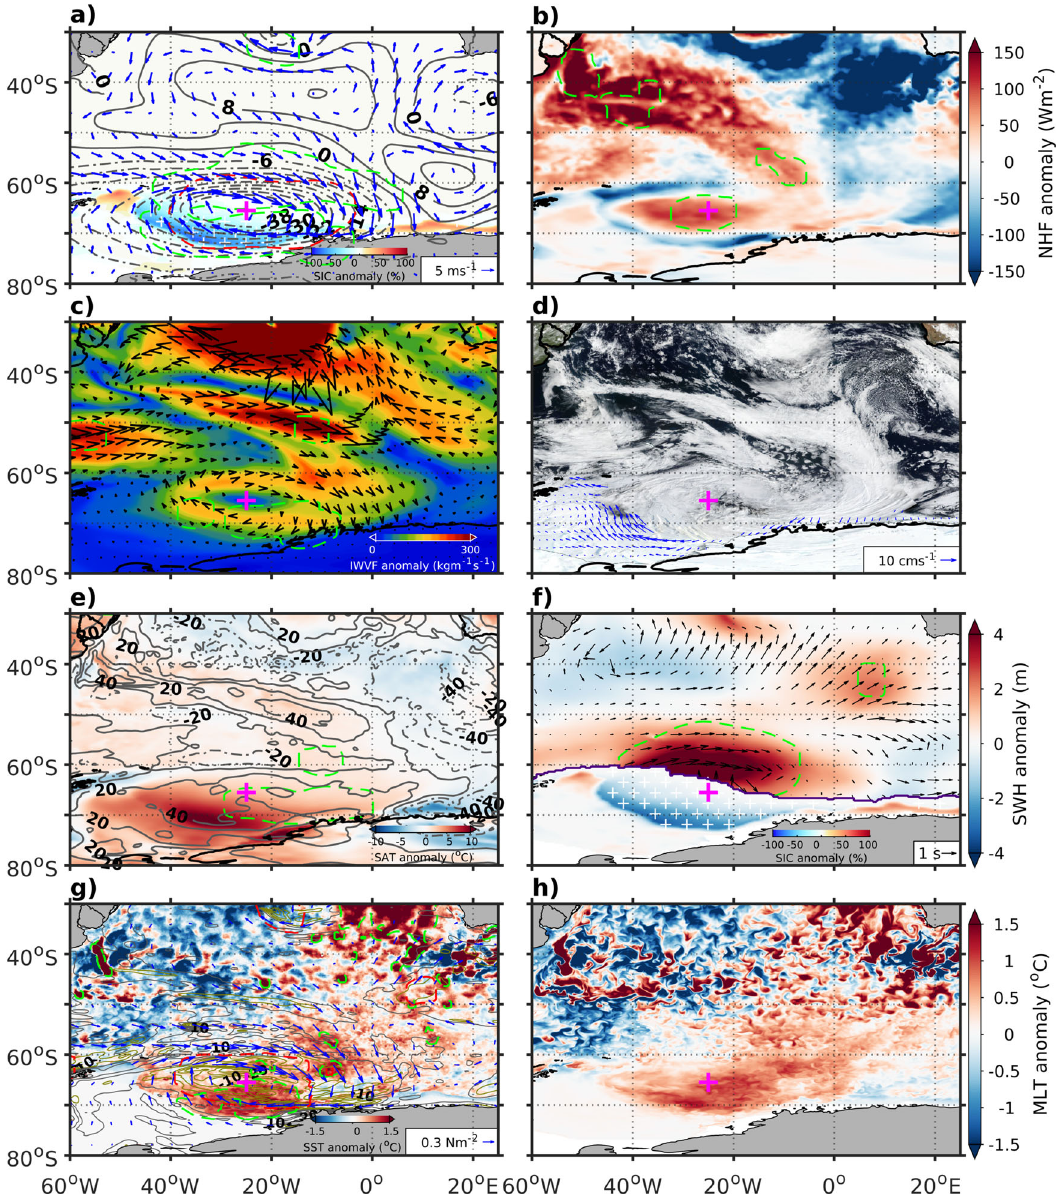
Fig. 3 Impact of the polar cyclone C1 on sea ice during 31 March 2019. a Anomalies of mean sea level pressure (MSLP) and wind vectors (blue arrows) are overlaid on anomalous sea ice concentration (SIC). Positive (negative) anomalies of MSLP are shown in solid (dashed) gray contours. The white plus marks showed the record low SIC values that remain outside from 1979 to 2020. b – e Anomalies in ( b ) net surface heat fl ux (NHF), ( c ) integrated water vapor fl ux (IWVF), ( d ) potential sea ice velocity (arrows) overlaid on cloud bands of cyclone from the Visible Infrared Imaging Radiometer Suite (VIIRS), ( e ) downward long-wave radiation (gray contours) overlaid on surface air temperature (SAT). f Signi fi cant wave height (SWH) anomalies are shown as color-shaded panel to the north of sea ice edge (purple line) with wave direction and period (black arrows) of combined wind waves and swells. The color-shaded panel to the south of the sea ice edge shows anomalous SIC. g, h Anomalies in ( g ) sea surface temperature (SST), wind stress vector (blue allows), negative wind stress curl (green contours, N m − 3 ), positive wind stress curl (gray contours) and ( h ) ocean mixed layer temperature (MLT). Regions within red (green) dashed polylines have record low (high) values that remain outside from 1979 to 2020. Within this, the record low is shown for MSLP and wind stress curl, while the record high is shown for other variables. The pink plus mark shows the low-pressure centre of the cyclone. The anomalies are computed relative to the climatology of 1979 – 2008. occurrence of intense and explosive cyclones (Fig. 4d, Table 1). The the impact of cyclone C1 induced extreme changes in ocean- slowdown of the ice melting/reduction occurs through enhanced atmospheric conditions initiated the rapid decline in SIE (0.024 ‒ snow accumulation which hinders the conduction-driven heat loss 0.032 × 10 6 km 2 day − 1 ) from 31 March to 4 April 2019 (Fig. 2c). It is at the interface between ocean and sea ice. Also, the snowfall also noted that the atmospheric rivers associated with polar during the polar cyclones provides the freshwater in fl ux to the cyclones bring enhanced precipitation 63 on sea ice cover which can ocean mixed layer that might have partly played a role by slowing slowdown the ice melting/reduction. Anomalously high precipita- down the ice melting/reduction. tion (~1.13 – 2.72 cm) in form of snowfall was observed during the npj Climate and Atmospheric Science (2022)